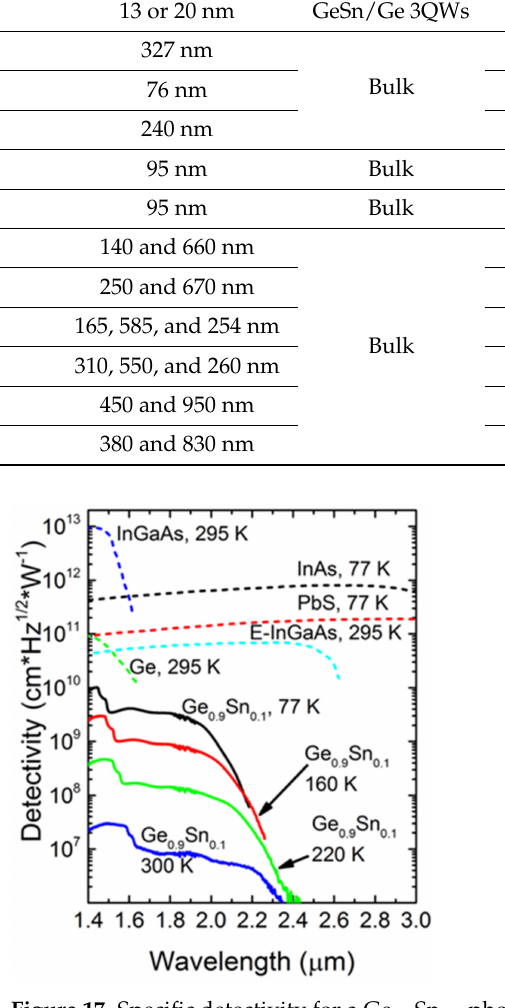
Figure 17. Specific detectivity for a Ge 0.9 Sn 0.1 photoconductive detector at temperatures of 77,